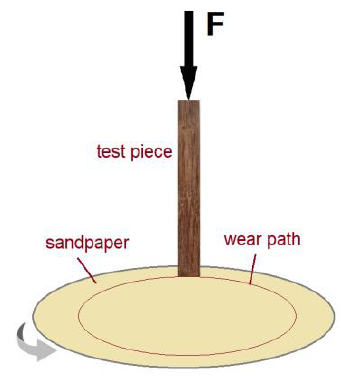
Figure 4. Schematic representation of the abrasive wear testing.